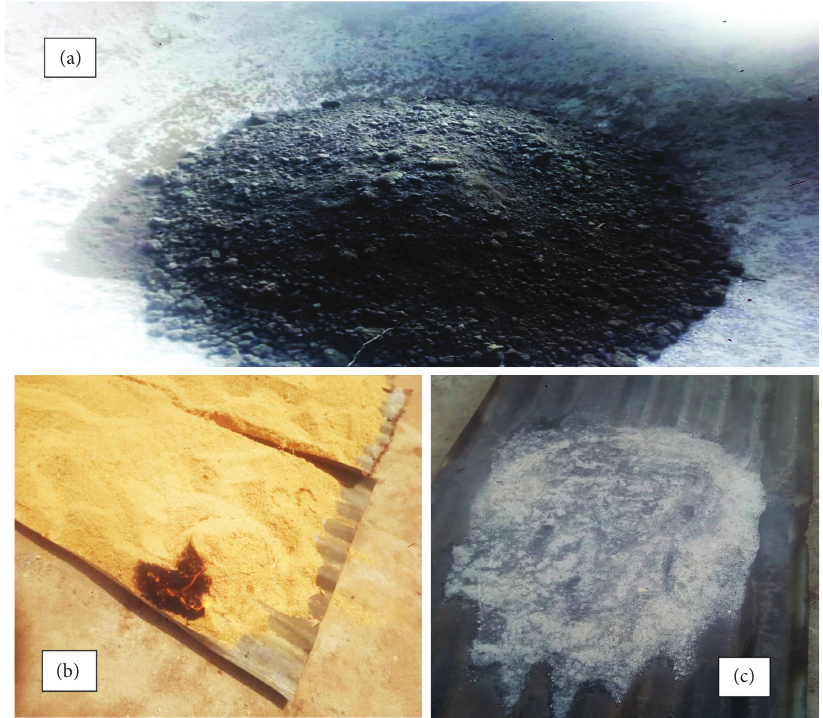
Figure 6: Materials preparation: (a) sundried BCS, (b) sundried sawdust (SD), and (c) combusting